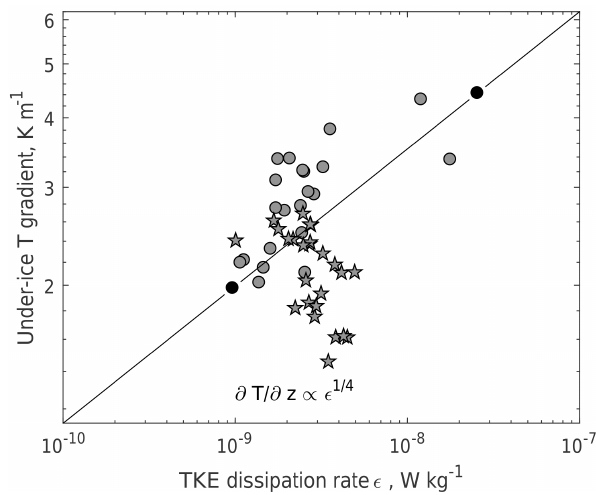
Figure 9. Relationship between the TKE dissipation rate and the temperature gradient in the uppermost part of the IL covered by the measurements (5–7cm under ice). Instead of a least-square approx- imation, a simple line is drawn connecting the minimum and the maximum of ε (full black circles): the slope of the line is 0 . 251. Stars mark the measurements during the period of “no wind-driven oscillations” (26 May 2014